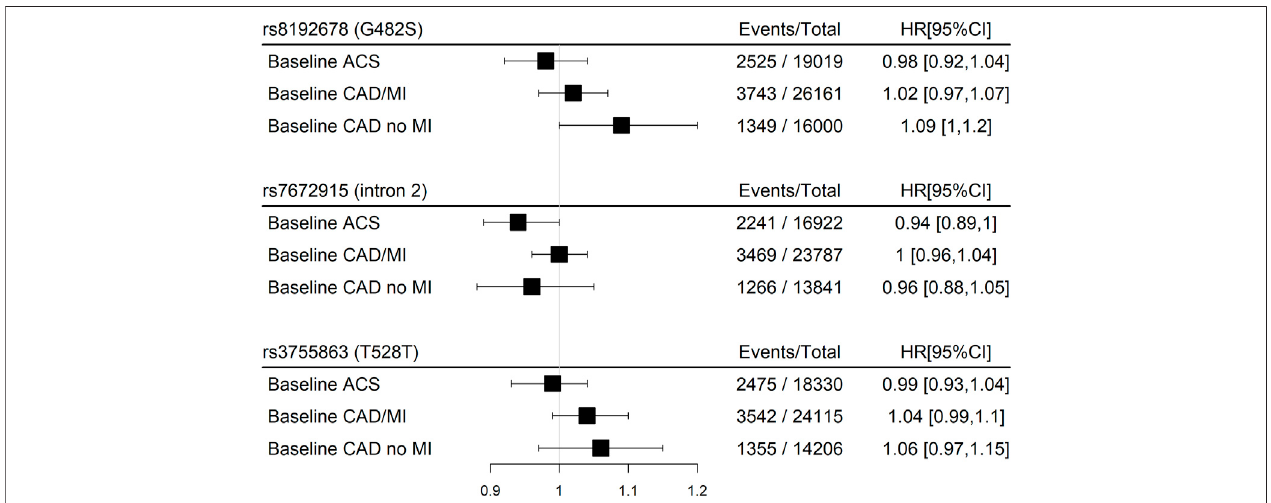
FIGURE 4 | Meta-analyses pooled results of the associations between three SNPs in the PPARGC1A gene and the main outcome (CHD death or myocardial infarction) in participants with baseline CHD within GENIUS-CHD using an additive, fi xed-effect model strati fi ed for the baseline CHD subtype (p homogeneity > 0.05 for all outcomes).Abbreviations: ACS, Acute Coronary Syndrome; CAD, Coronary Artery Disease; MI, Myocardial